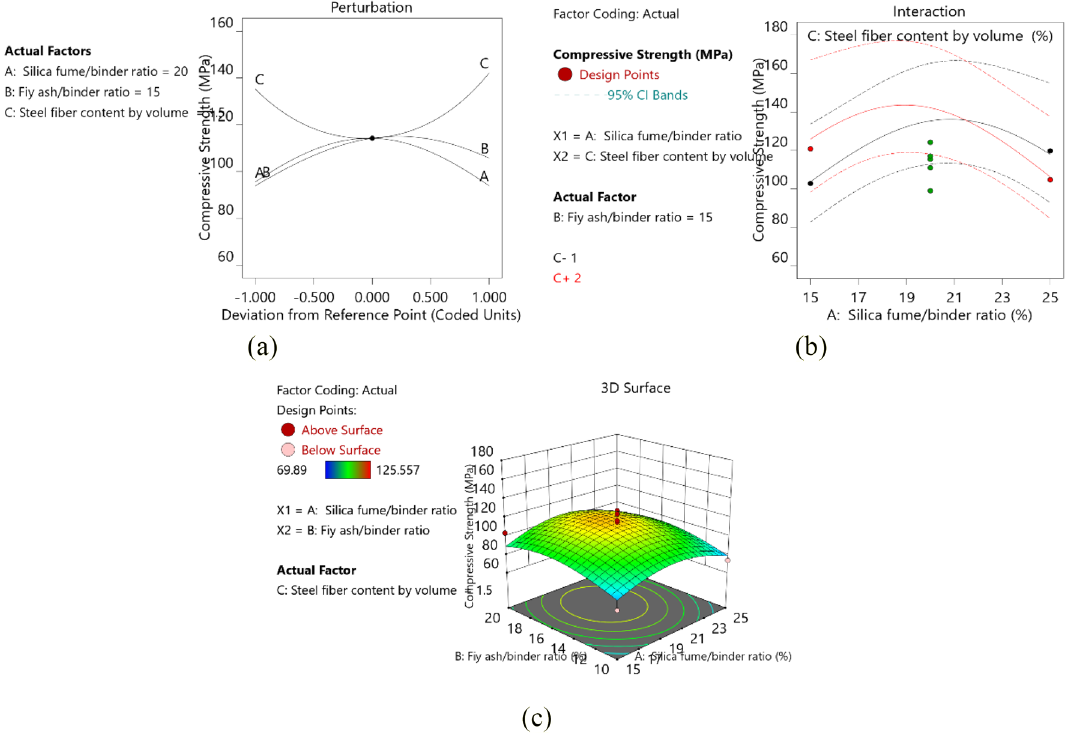
Figure 4. ( a ) Perturbation plot for compressive strength. ( b ) AC interaction, B = 15. ( c ) 3D response diagram of compressive